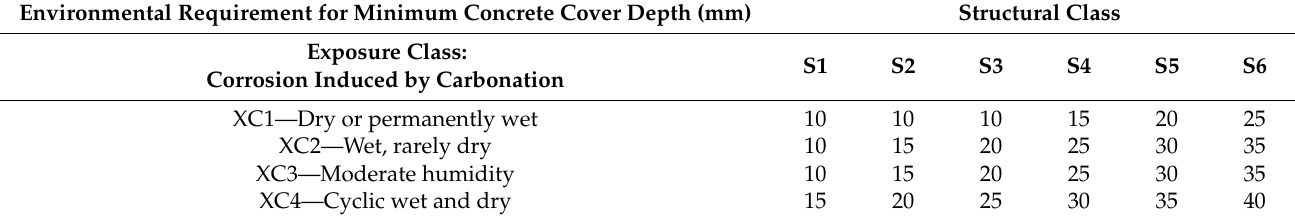
Table 2. Minimum concrete cover depth (mm) for corrosion induced by